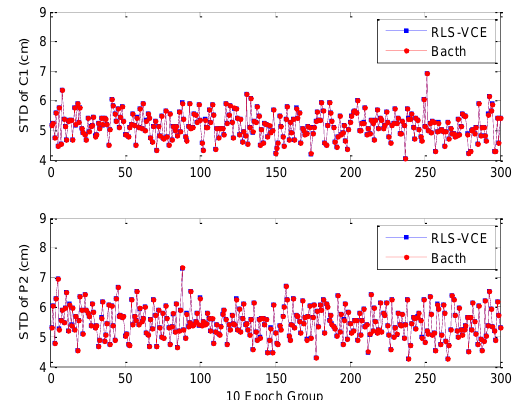
Fig. 1 Estimated standard deviations of GPS code observations (C1 and P2) for Trimble R7 receiver in cm for both batch and recursive methods For a better view, the estimated standard deviations of four GPS observation types for both solutions are presented in Table 2 (in mm). As mentioned, the final estimates of the unknown (co)variance parameters are just the arithmetic mean of the individual estimates over the 300 groups for both batch and recursive